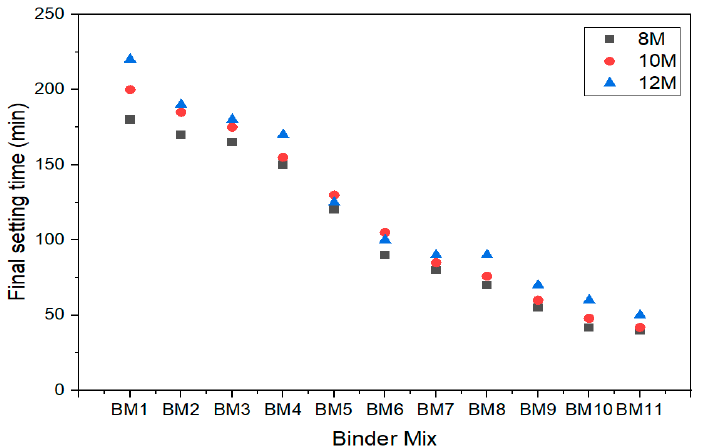
Figure 6. Final setting time of paste.